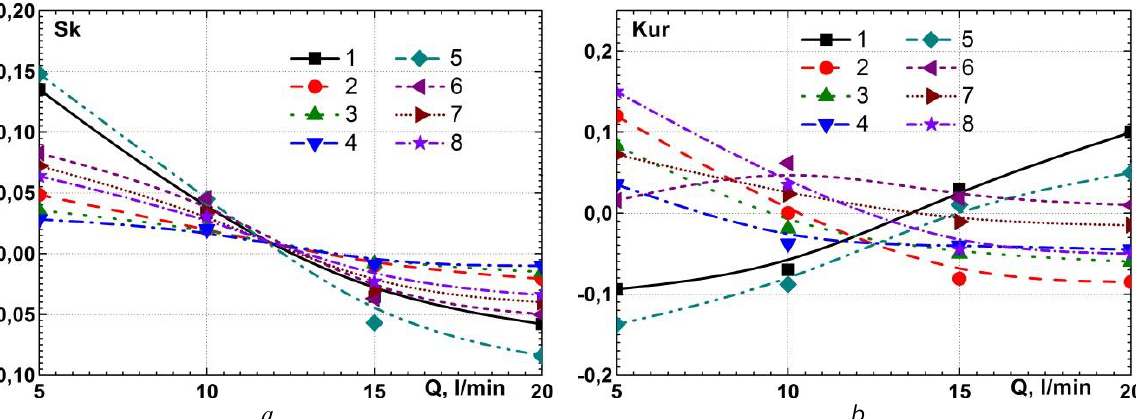
Figure 6. Coefficients of the skewness (a) and kurtosis (b) of the field of pressure fluctuations about the side jet in the near wake of the bileaflet mechanical mitral heart